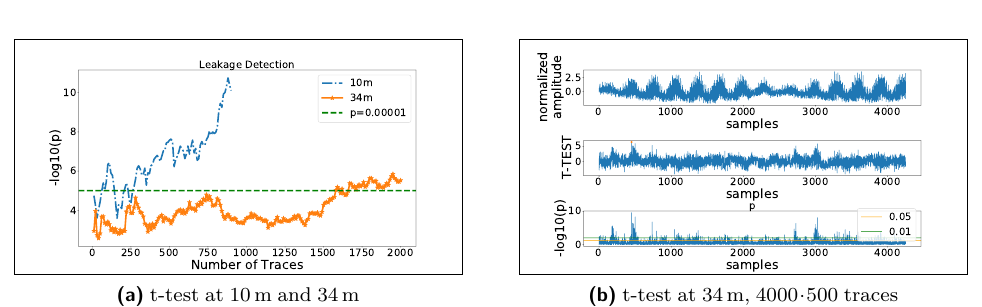
Figure 18: The t-test succeeds even at 34